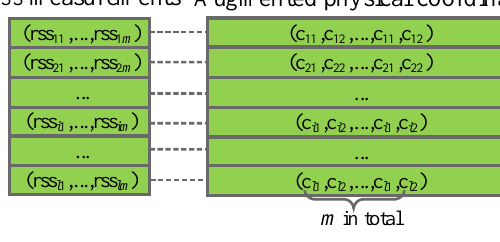
Figure 1. Result of location